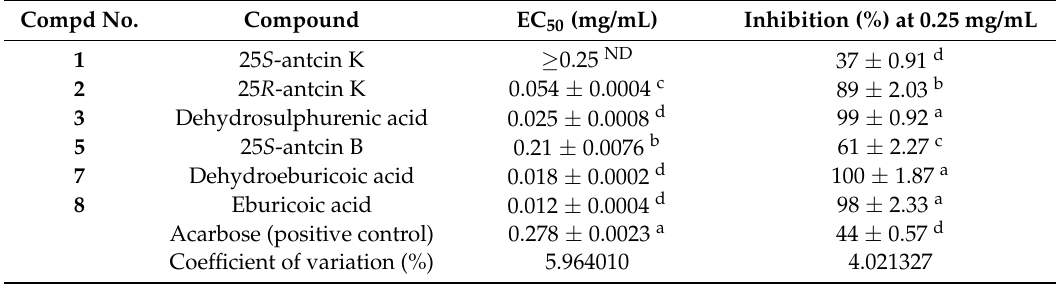
Coefficient of variation (%) 5.964010